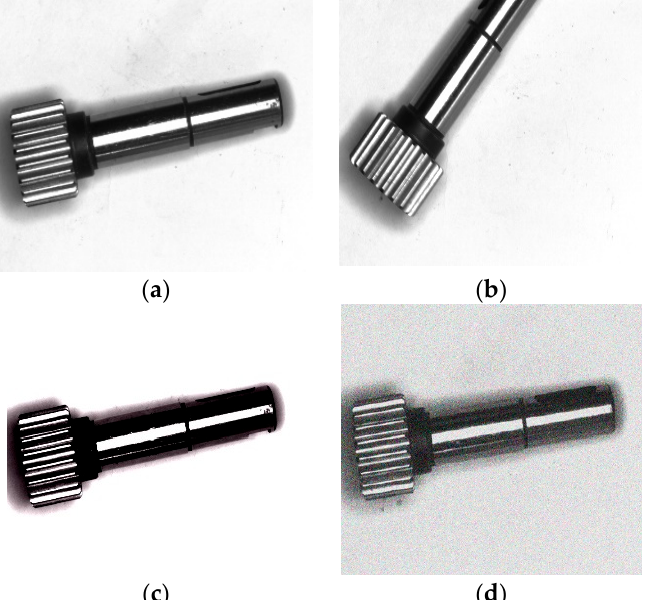
Figure 7. Image acquisition platform.